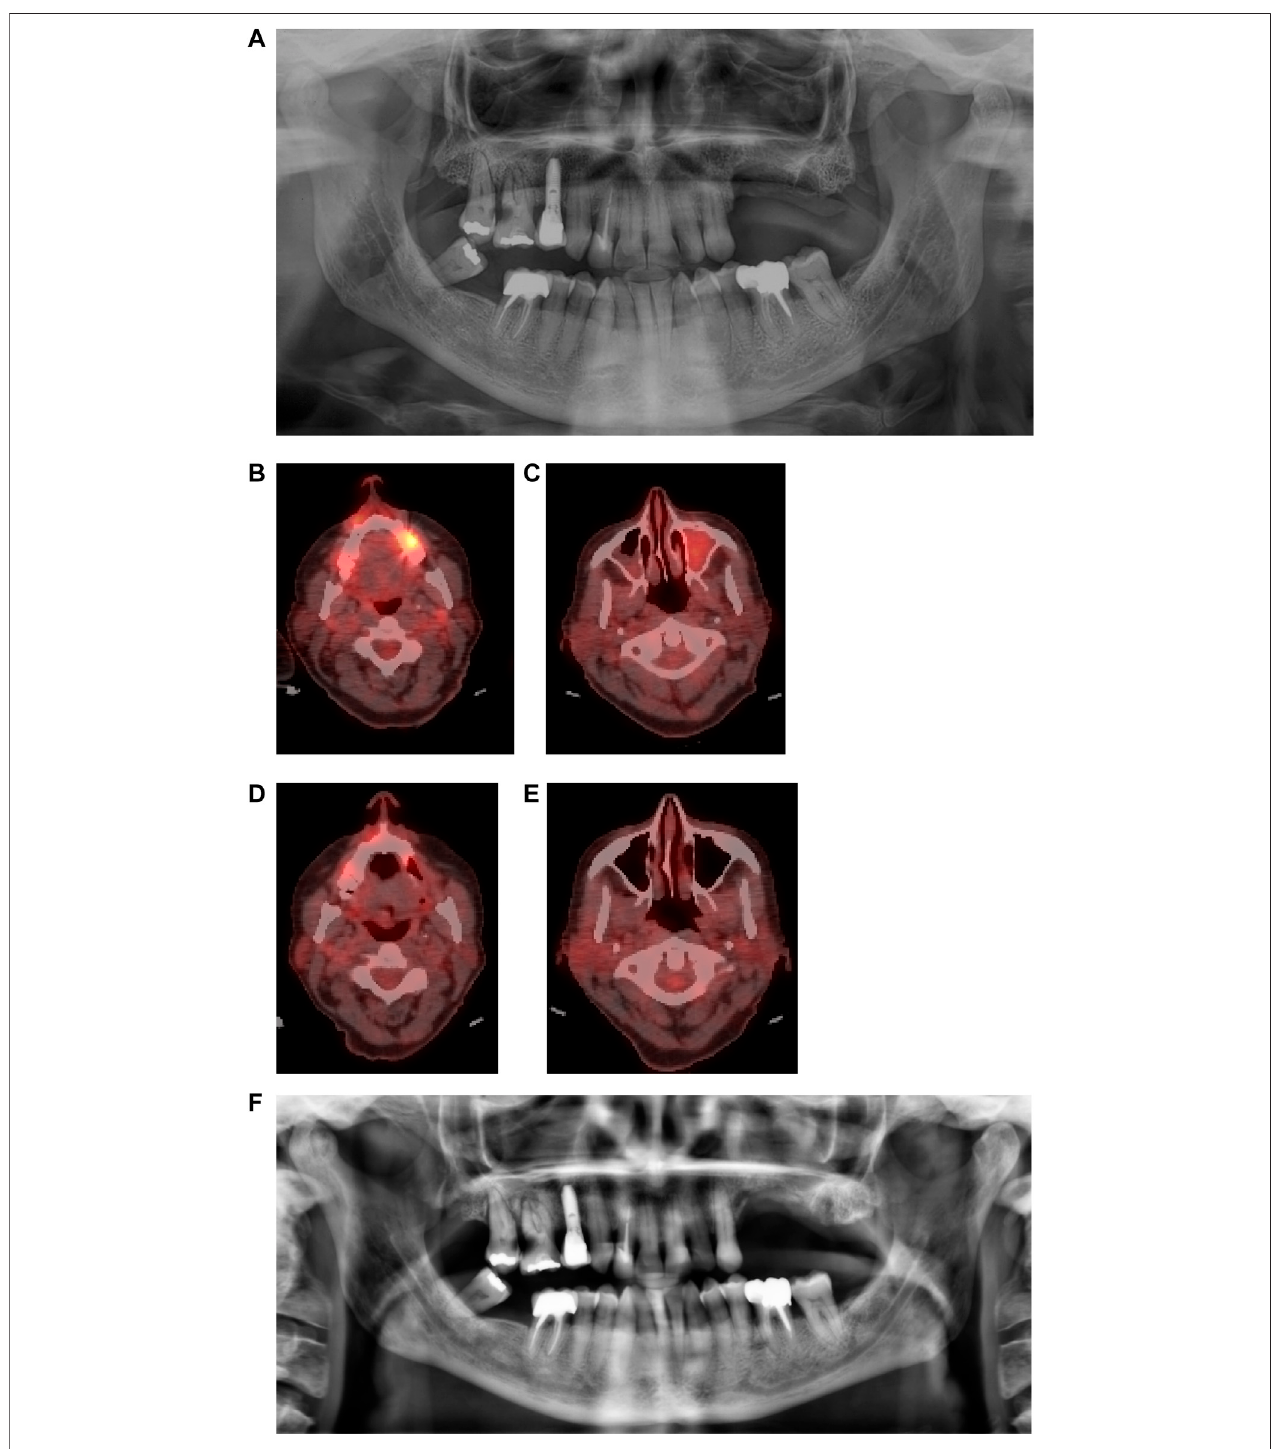
FIGURE 7 | Patient 6 (A) Pre-operative orthopantomography (OPT) showing a stage 2 sector 2 MRONJ; (B,C) Positron-Emission Tomography (PET) before surgery,showing ahypermetabolic signal regardingtheMRONJ sitein sector 2, and anin fl ammatoryleft maxillarysinus; (D,E) Threemonthspost-operative PET, witha considerable decrease of the hypermetabolic signal and a healthy left maxillary sinus. (F) Six months post-operative OPT with osseous neoformation in sector 2.